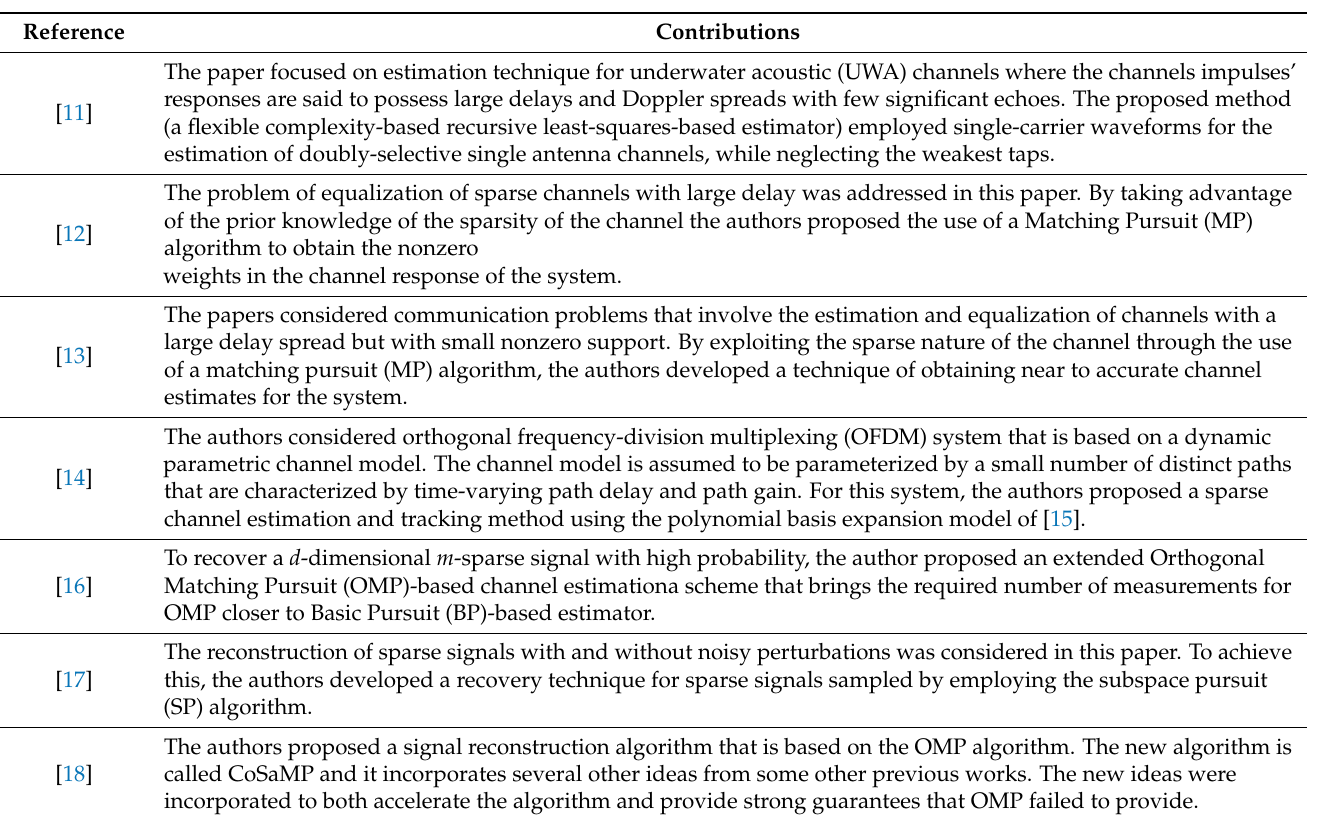
Table 1. Summary of the reviewed relevant